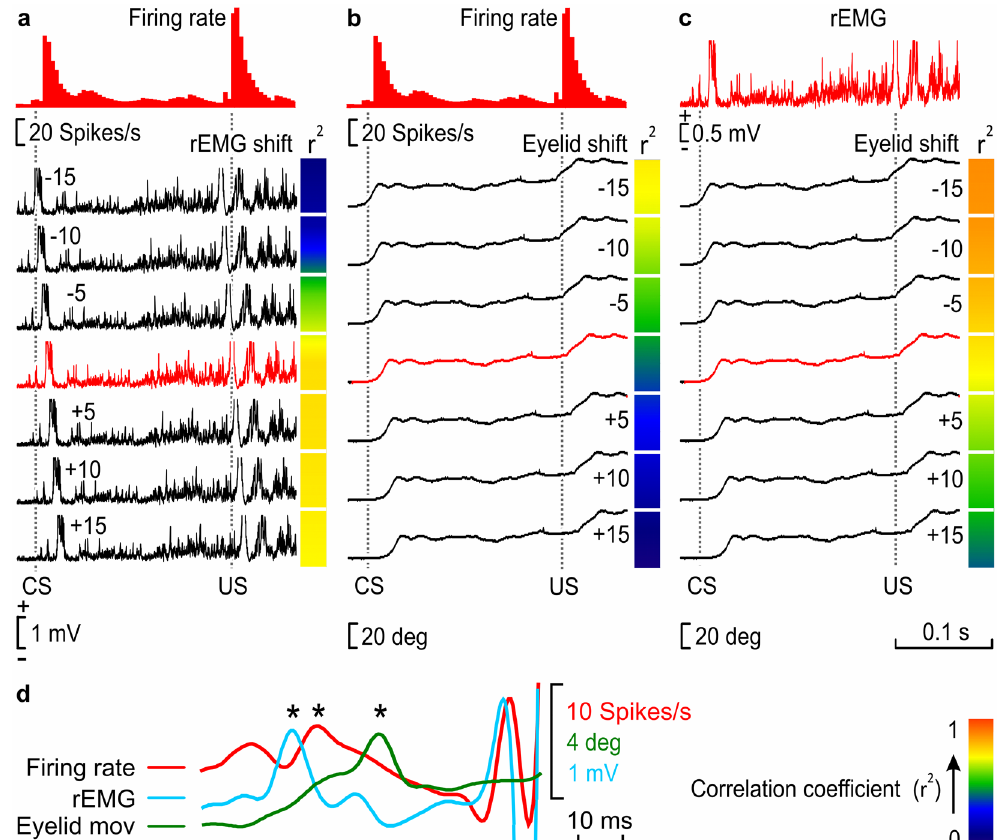
Figure 5. Timing correlation between firing rate, rEMG, and lower-eyelid position for CRs collected during classical eyeblink conditioning. We calculated the coefficient of determination (r 2 ) between the firing rate of type A neurons and the rEMG ( a ), the firing rate and eyelid position ( b ), and the rEMG and eyelid position ( c ) in 10 averaged trials. ( a ) A representation of r 2 values between the firing rate of IPN neurons and the corresponding rEMG (red trace), when the rEMG was shifted − 15 ms, − 10 ms, − 5 ms, + 5 ms, + 10 ms, and + 15 ms (black traces) from the original timing (0 ms, red trace) recorded during a conditioning session of a WT trained mouse during a delayed conditioning paradigm. We compared regions of the CS-(US − 20 ms) interval and delimited each one by turning points automatically detected in the firing rate. For each comparison, the collected r 2 value is represented by a colored square to the right of each rEMG recording. ( b ) Same correlation was calculated for neuron firing rate vs. eyelid position. ( c ) Same correlation is calculated for rEMG vs. eyelid position. The calibration for color gradient values is shown at the bottom right in ( d ). Higher r 2 values corresponding to negative-shifted recordings indicate a delay with respect to the correlated recording (in a and b , the firing rate, and in c , the rEMG), whereas higher r 2 values corresponding to positive-shifted recordings indicate an advance with respect to the correlated recording. ( d ) Superimposition of smoothed recordings of the firing rate, rEMG, and eyelid movement, corresponding to the last 80 ms of the CS-US interval of the unshifted recordings shown from ( a ) to ( c ), showing the timing appearance of bursts of the CR ( * ). Note that, whereas eyelid movement is delayed with respect to the firing rate ( b ) and, obviously, with respect to the rEMG ( c ), interestingly the rEMG is advanced with respect to the firing rate ( a